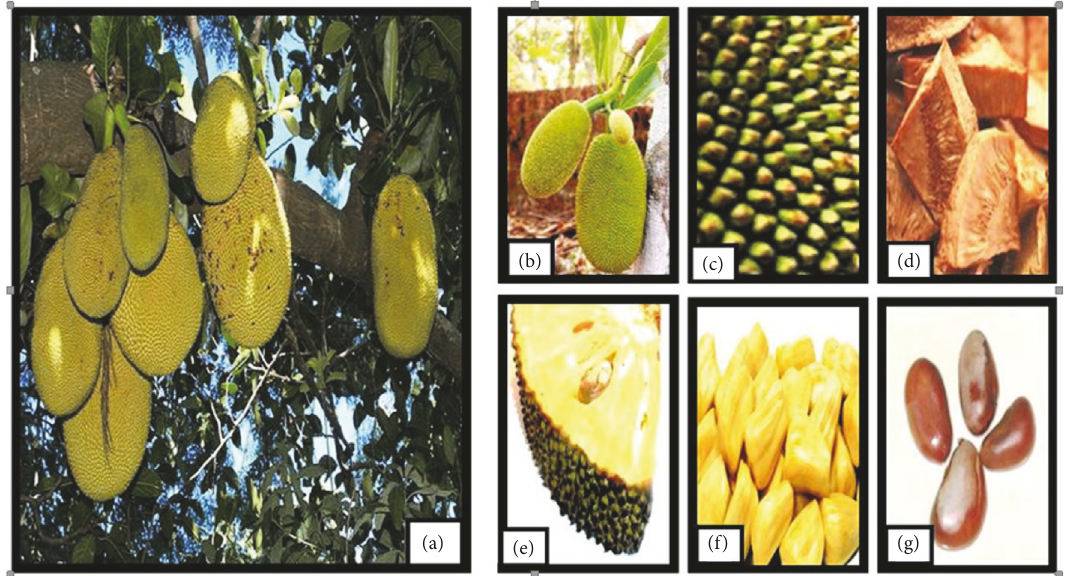
Figure 1: (a) Jackfruit tree with the fruits of different sizes; (b) jackfruit tree with the fruits in different stages of fruiting; (c) the jackfruit with conical carpel apices; (d) raw jackfruit pieces used for curries; (e) the interior of a ripe jackfruit with the seed; (f) the ripe eatable flesh of jackfruit; and (g) the jackfruit seed (source: